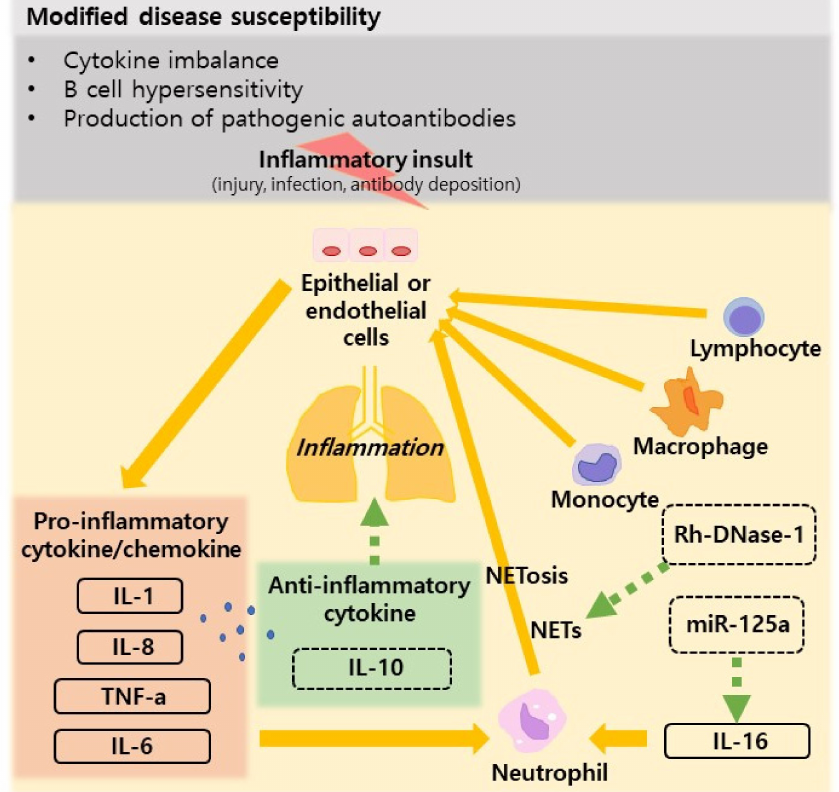
Figure 1. Pathogenesis of lung involvement in SLE